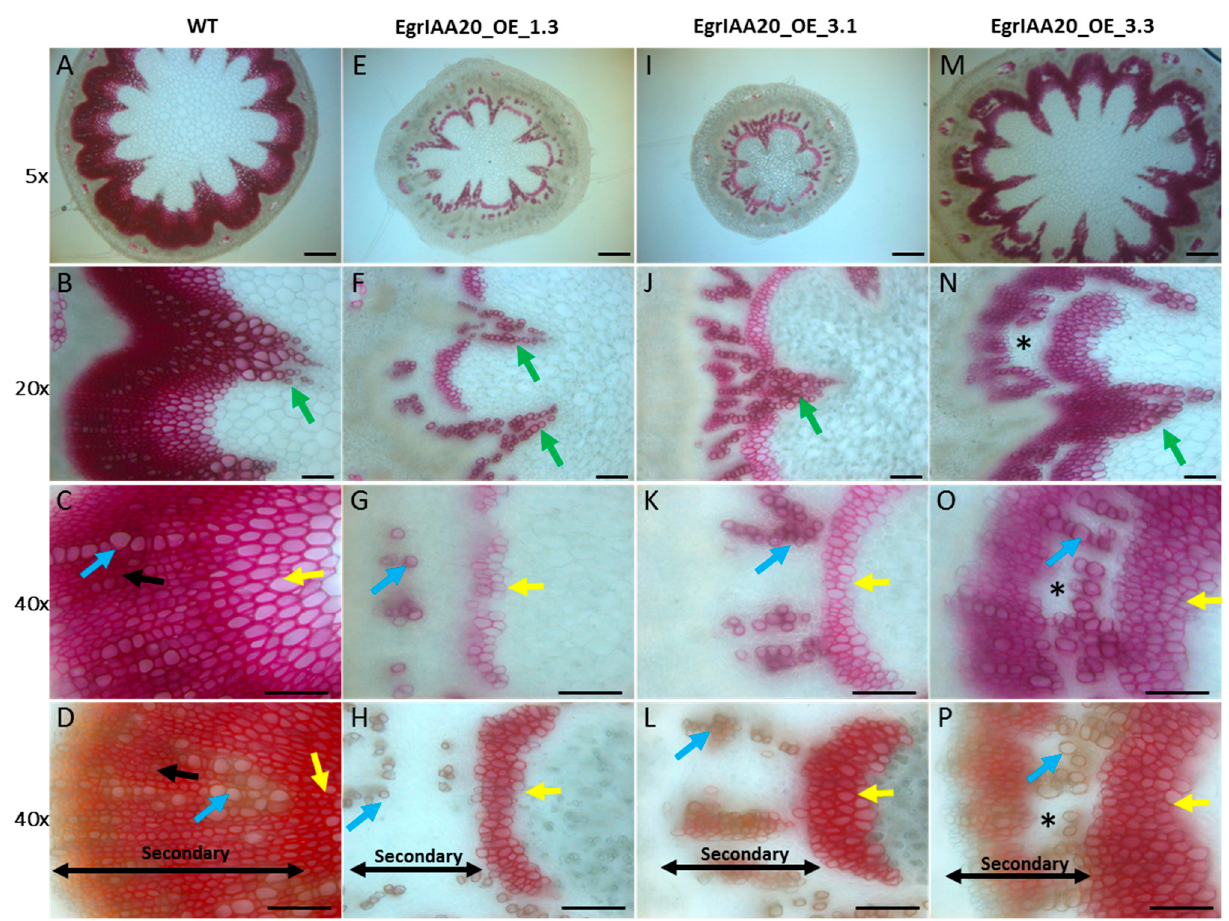
Figure 7. EgrIAA20 overexpression specifically repressed secondary fibers but not primary fibers nor secondary vessels in Arabidopsis inflorescence stems. Left panel ( A – D ) shows cross section of inflorescence stems at the basal part of wild-type control, <1 cm to the rosette level, 62-day-old plants; 5×, 20×, and 40× objective image for the first raw, second and third raw, respectively, using Phloroglucinol-HCl staining, which stains the lignin polymers in the SCW of xylem cells into red- purple; the last raw was 40× objective observation image stained with Maüle method, which stains the fiber cells into bright red color due to the syringyl unit (S unit) of lignin, indicated by yellow and black arrows, and stains the vessels in to brown due to the G unit of lignin, indicated by blue arrow. The corresponding cross sections from three independent EgrIAA20 overexpressing lines are shown in the middle and right panels: EgrIAA20_OE_1.3 (strong line, middle left panel ( E – H )), EgrIAA20_OE_3.1 (strong line, middle right panel ( I – L )), EgrIAA20_OE_3.3 (weak line, right panel, ( M – P )). Green arrows indicate primary xylem cells in fascicular bundles; blue arrows indicate sec- ondary vessel cells (vessel II); yellow arrows indicate primary fiber cells (fiber I); black arrows indicate secondary fiber cells (Fiber II). * indicates staining gaps dispersed in the secondary growth region. The first to third raw used Phloroglucinol-HCl staining; the bottom raw used Maüle staining methods. The secondary growth regions are indicated by double-arrow lines in the images stained by Maüle. For 5× objective observation images, scale bar = 200 µm, and for 20× and 40× objective observation images, scale bar = 50 µm.